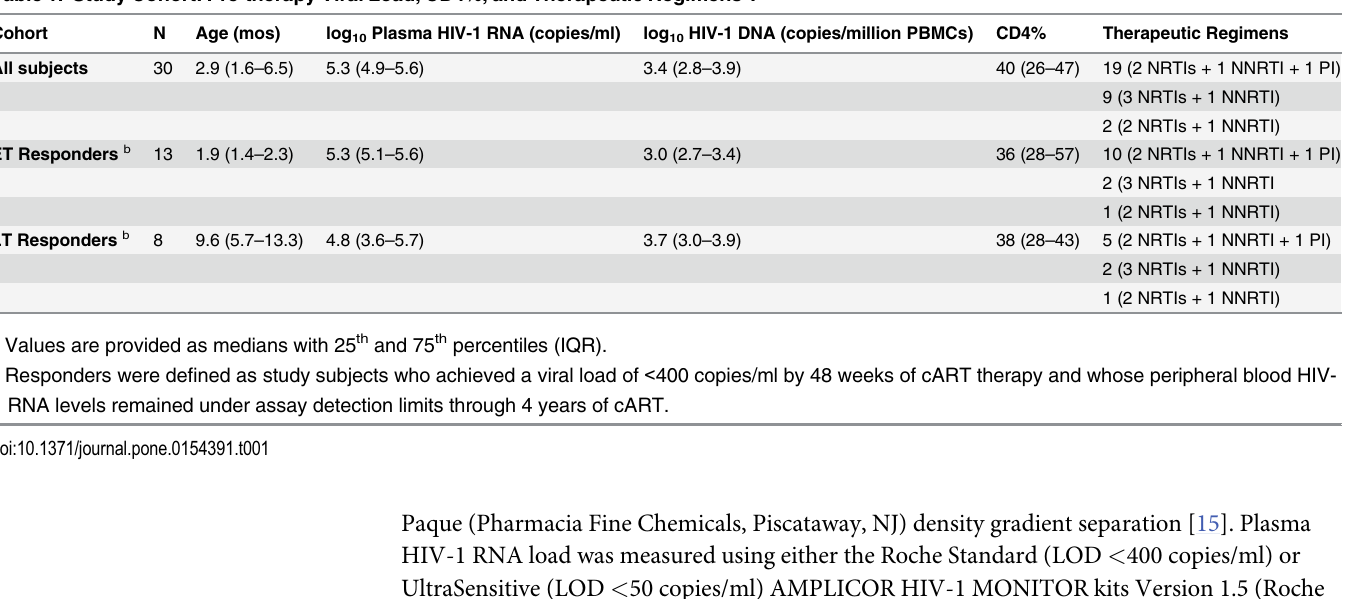
Table 1. Study Cohort: Pre-therapy Viral Load, CD4%, and Therapeutic Regimens a